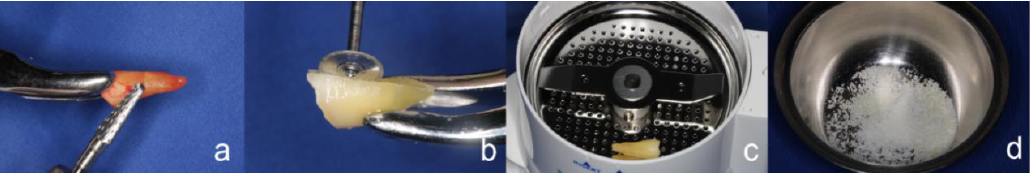
Figure 1. Dentin preparation. ( a ): A carbide bur was used to remove periodontal tissue and debris from the tooth root. In addition, restorations were eliminated. ( b ): A dentin shell was separated from the tooth root with a rotating diamond disc. ( c ): The remaining dentin was particulated in a sterile disposable mill (Smart Dentin Grinder). ( d ): The particulated dentin was kept in a sterile container.